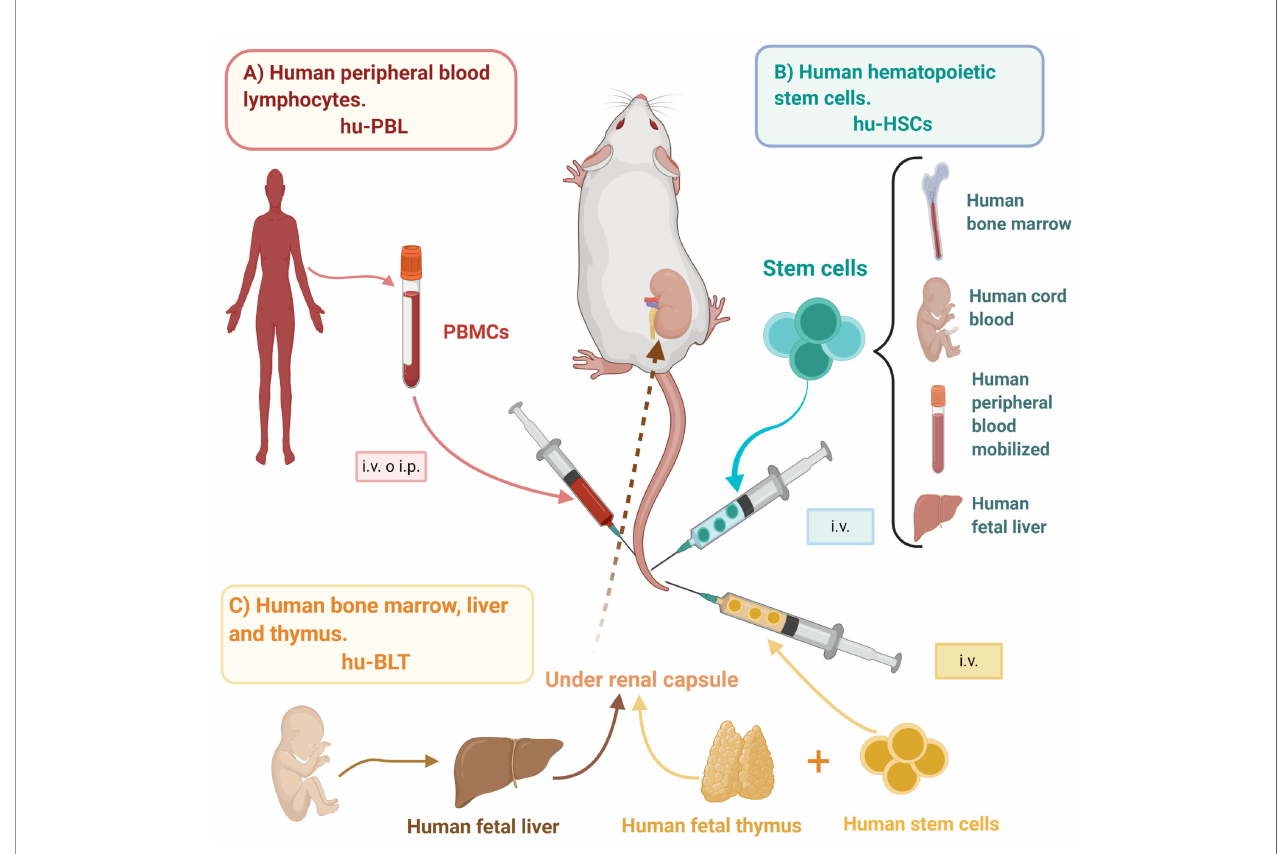
FIGURE 1 | Mice humanization strategies. Mice/human chimeras originate from immunode fi cient mice engrafted with different sources of human cells or tissues able to reconstitute a human-like immune response, such as (A) hu-PBL: PBMCs are obtained from healthy donors and i.v. or i.p. inoculated, (B) hu-HSCs: HSCs may be obtained from bone marrow, umbilical cord blood, peripheral blood, or fetal liver, and i.v. inoculated into either adult or newborn mice, and (C) hu-BLT: Bone marrow stem cells and tissues from fetal liver and thymus are transplanted into previously irradiated mice, speci fi cally under the renal capsule. hu-BLT, human bone marrow, liver, and thymus; hu-HSCs, human hematopoietic stem cells; hu-PBL, human peripheral blood lymphocytes; i.p., intraperitoneal; i.v., intravenous; PBMCs, peripheral blood mononuclear cells. Created with